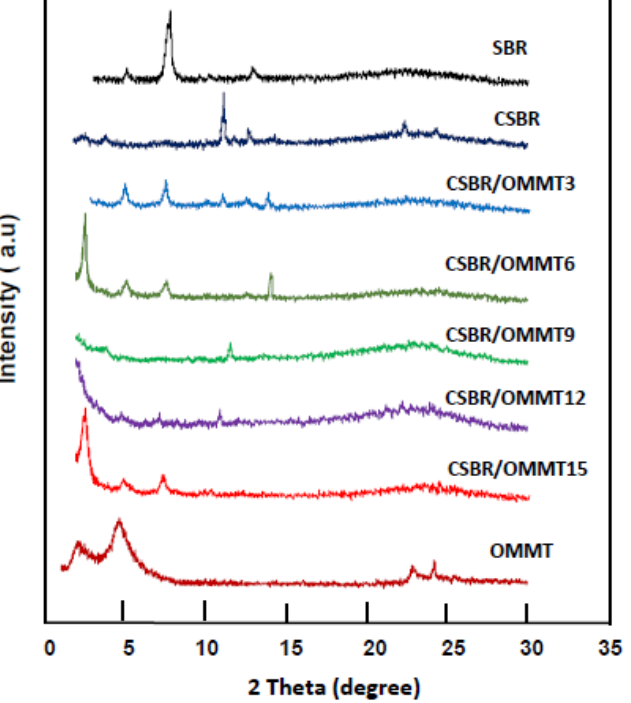
Figure 1. FTIR spectra of SBR, CSBR and CSBR/OMMT nanocomposites with different OMMT contents.